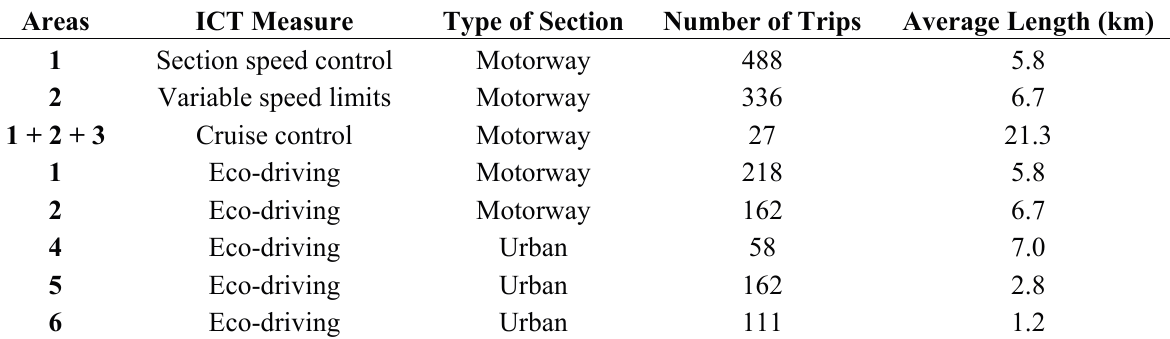
Table 1. Areas of implementation according to Figure 1, number of valid trips and average length per tested ICT